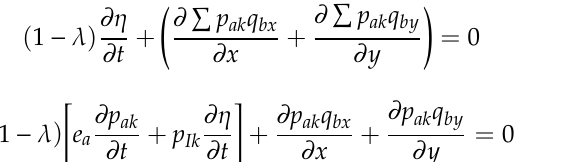
Figure 3. Flow discharge during 2010 and 2016 floods.